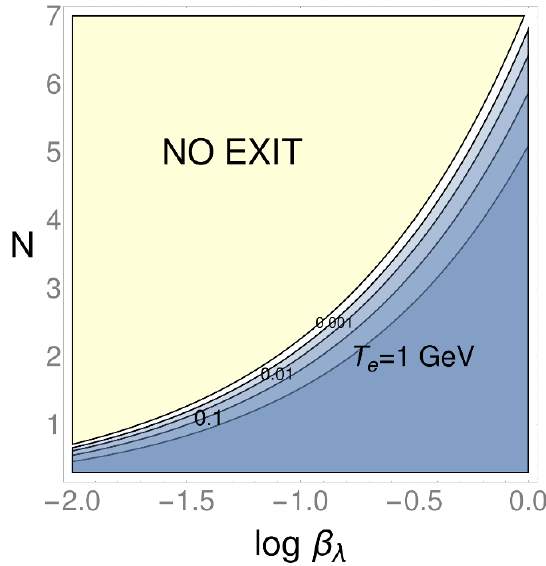
Figure 3 . Lines of (cid:12)xed exit temperature ( T e = 1 ; 0 : 1 ; 0 : 01 ; 0 : 001 GeV from below to above) for type I models, and no exit region eq.